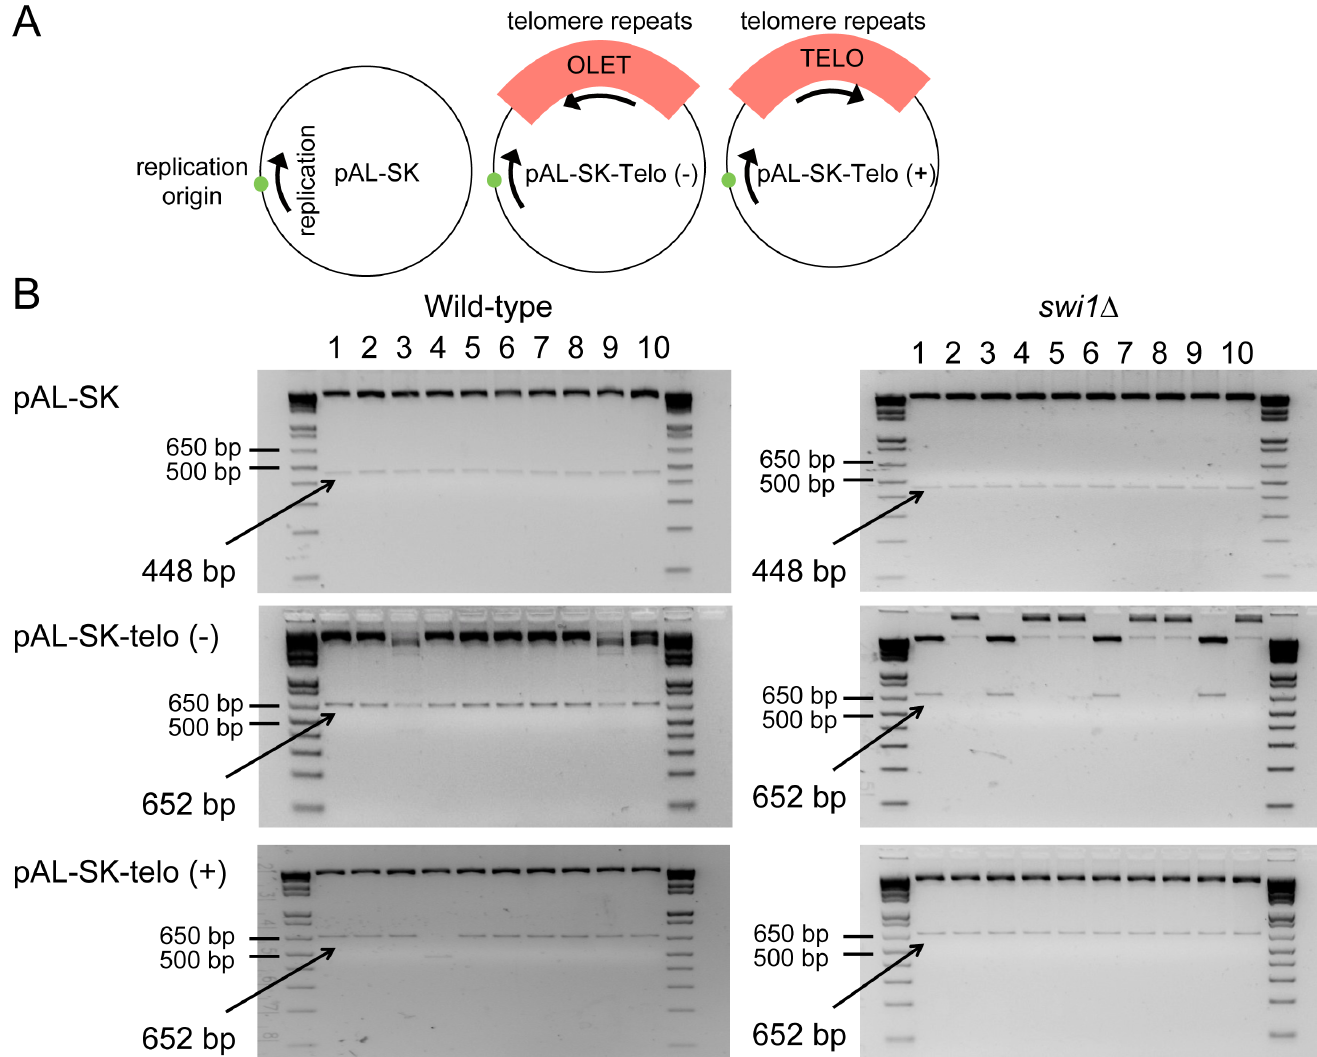
Fig 4. Plasmid instability associated with telomeric repeats. (A) Schematic diagram of pAS-SK-telo plasmids. (B) Wild-type and swi1 Δ cells were transformed with either the empty pAL-SK plasmid or the pAL-SK carrying a 300 bp. telomere tract in normal (+) or reverse (-) orientation relative to the replication origin of the plasmid. Recovered plasmid from 10 yeast colonies was amplified in bacteria, and 10 bacterial colonies per treatment were analyzed by restriction digestion with PvuII in 3% agarose gels stained with EtBr. Each column represents and independent bacterial colony. Size markers are shown and expected restriction fragment size is shown in